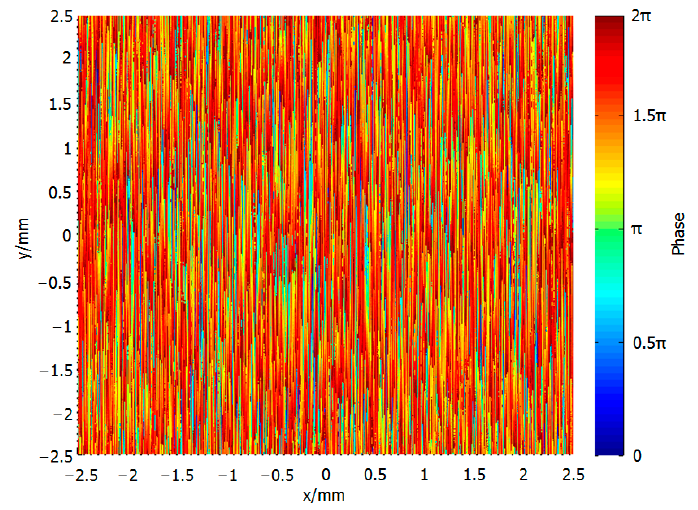
Figure 7. Phase distribution of the DOE.